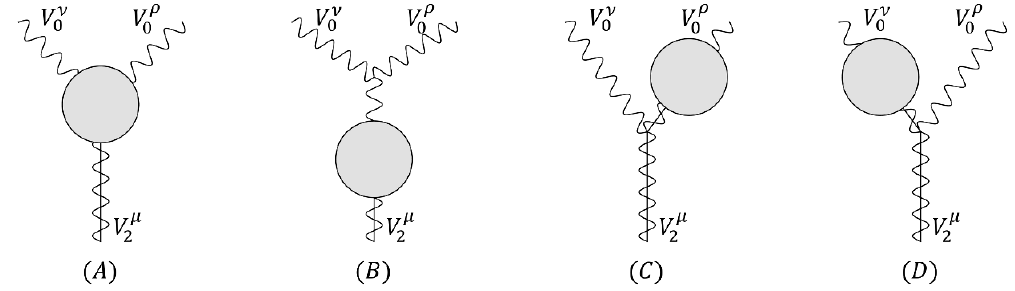
Figure 7 . Contributions to the V 2 { V 0 { V 0 vertex. See caption of (cid:12)gure 4 for more explanations.